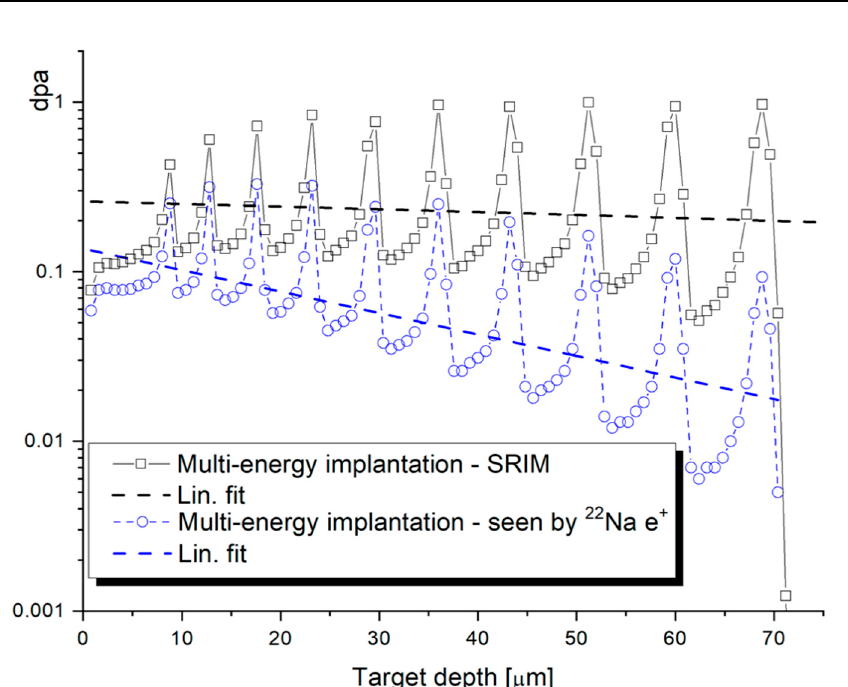
Figure 8. Damage profile in Fe induced by He implantation with a total fluence of 5.5 × 10 17 cm − 2 . Displacement damage–dpa profile as simulated by SRIM (black squares) vs. actual profile as ‘visible’ to positrons from conventional 22 Na source (blue circles).